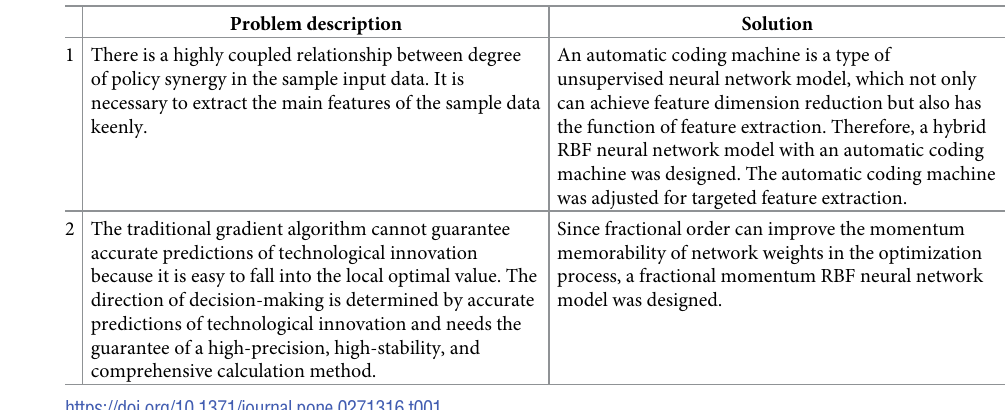
Table 1. Problem descriptions and